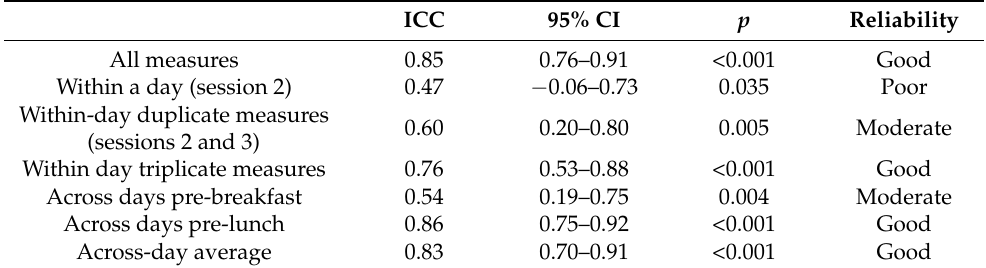
Table 3. Test-retest reliability of carbohydrate detection thresholds within day and across days.